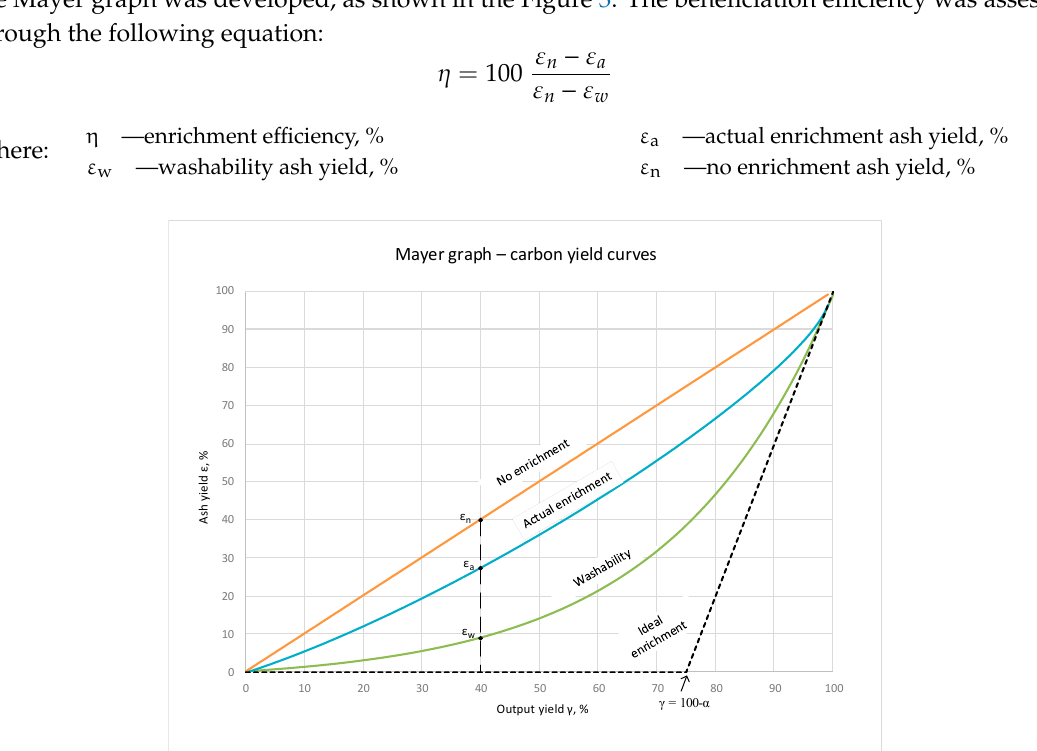
Figure 3. Mayer graph, presenting ash yield in the relationship to product yield (based on [57]).